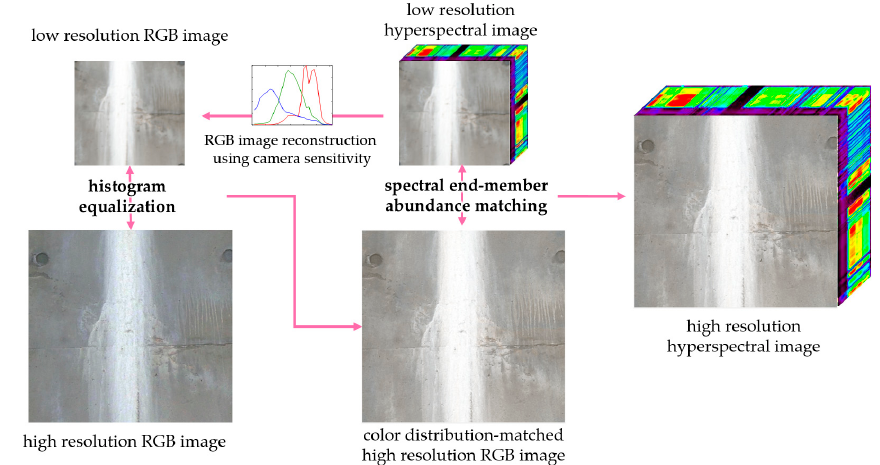
Figure 1. Overall framework of the proposed solution for hyperspectral super-resolution when spatial information of an Red-Green-Blue (RGB) image and a hyperspectral image (HSI) is mismatched.